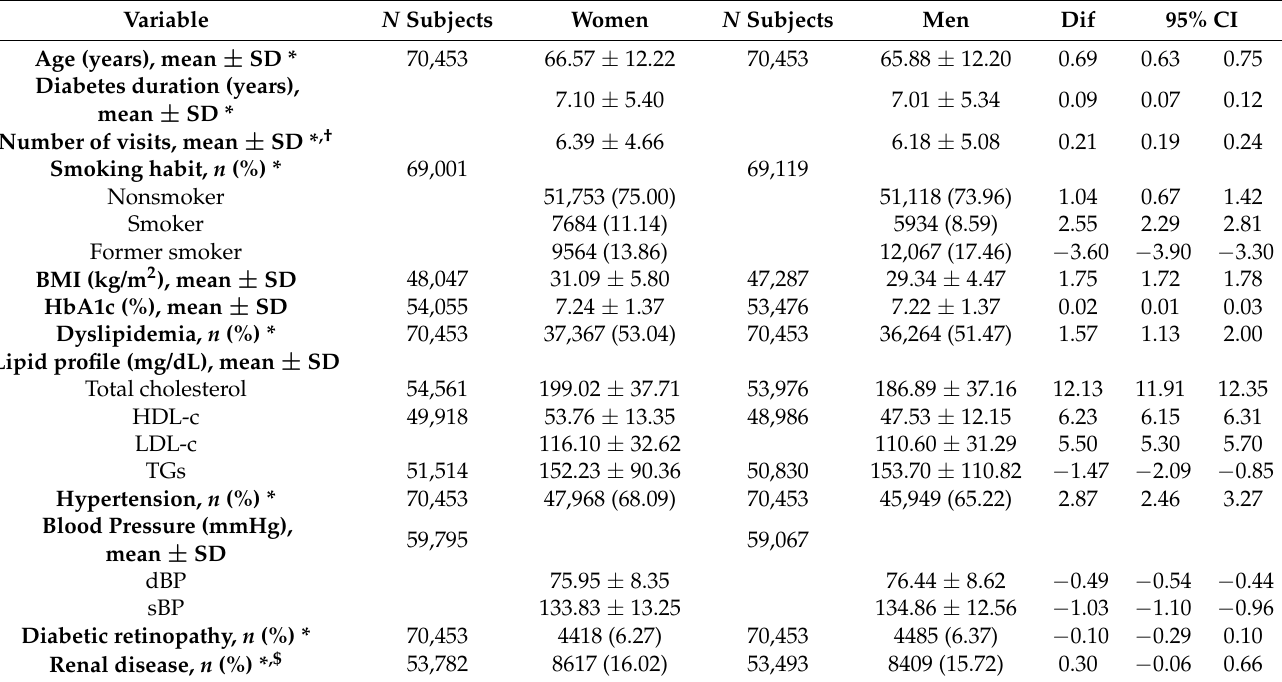
Table 1. Baseline characteristics of matched women and men with T2DM in primary prevention by